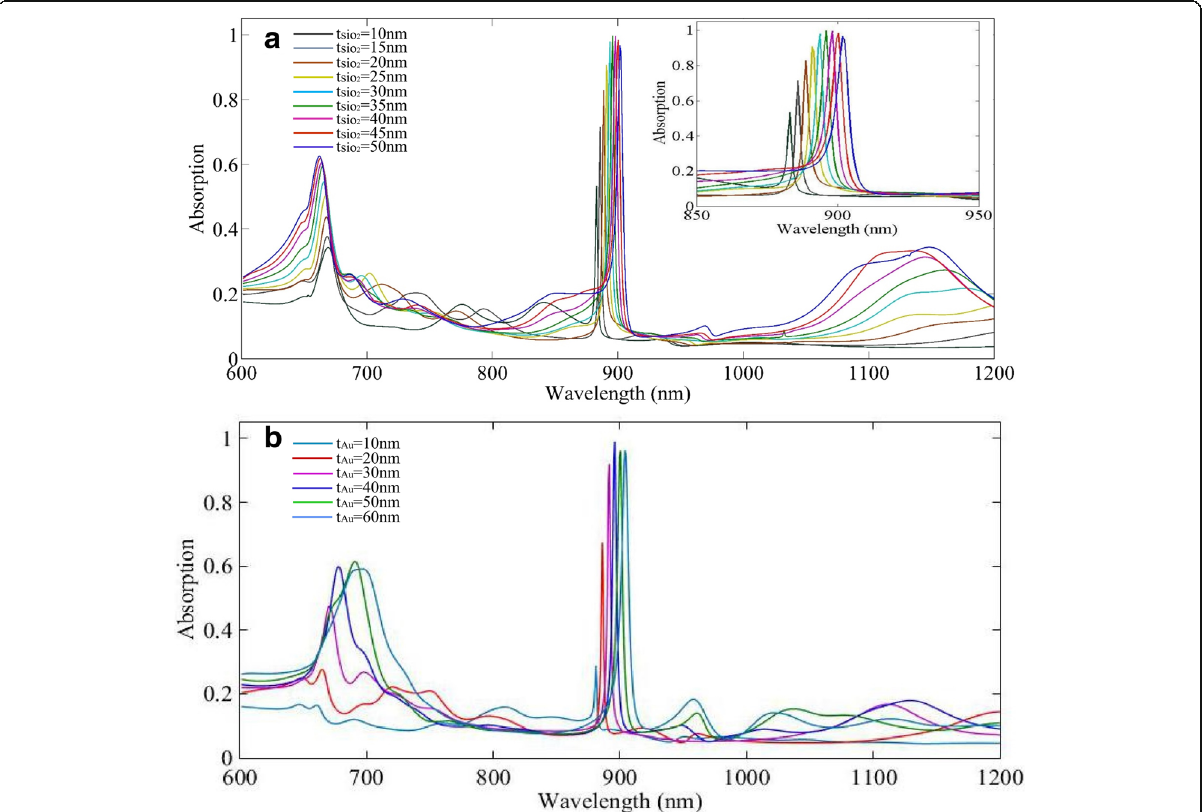
Fig. 3 a Absorption spectrum varies with thickness of SiO 2 layer increasing. b Absorption spectrum varies with thickness of top triangle Au array layer